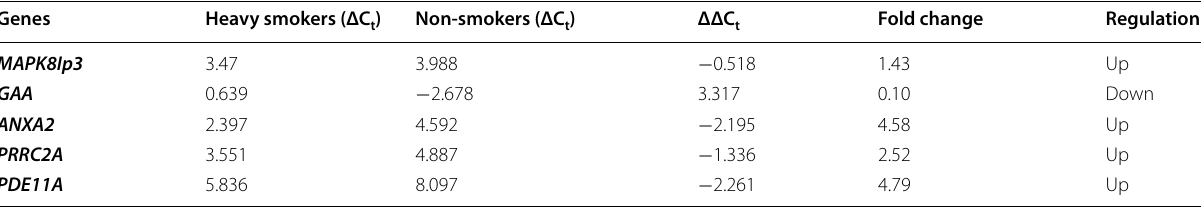
Table 5 Transcription level of MAPK8Ip3 , GAA , ANXA2 , and PRRC2A genes and fold change in spermatozoa of heavy smokers compared to non-smokers ( n =